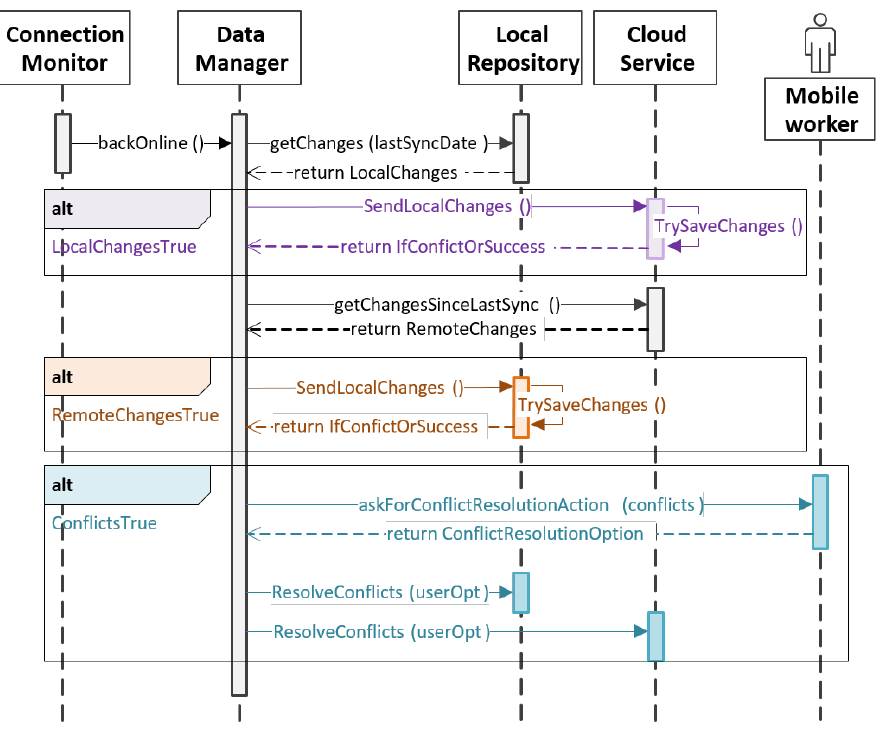
Figure 9. Sequence diagram for the mobile synchronization